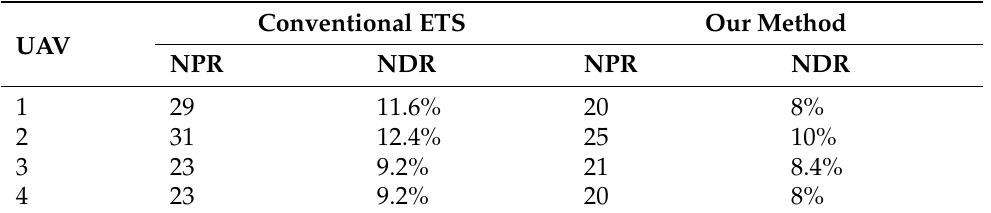
Table 1. Comparison of triggering numbers under different schemes UAV